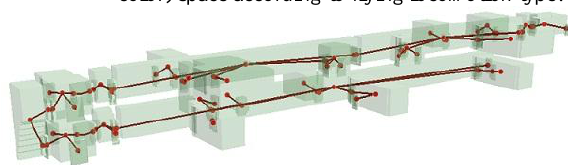
Figure 13. Obstacle (light maroon color) and navigable (green color) space according to flying locomotion type.